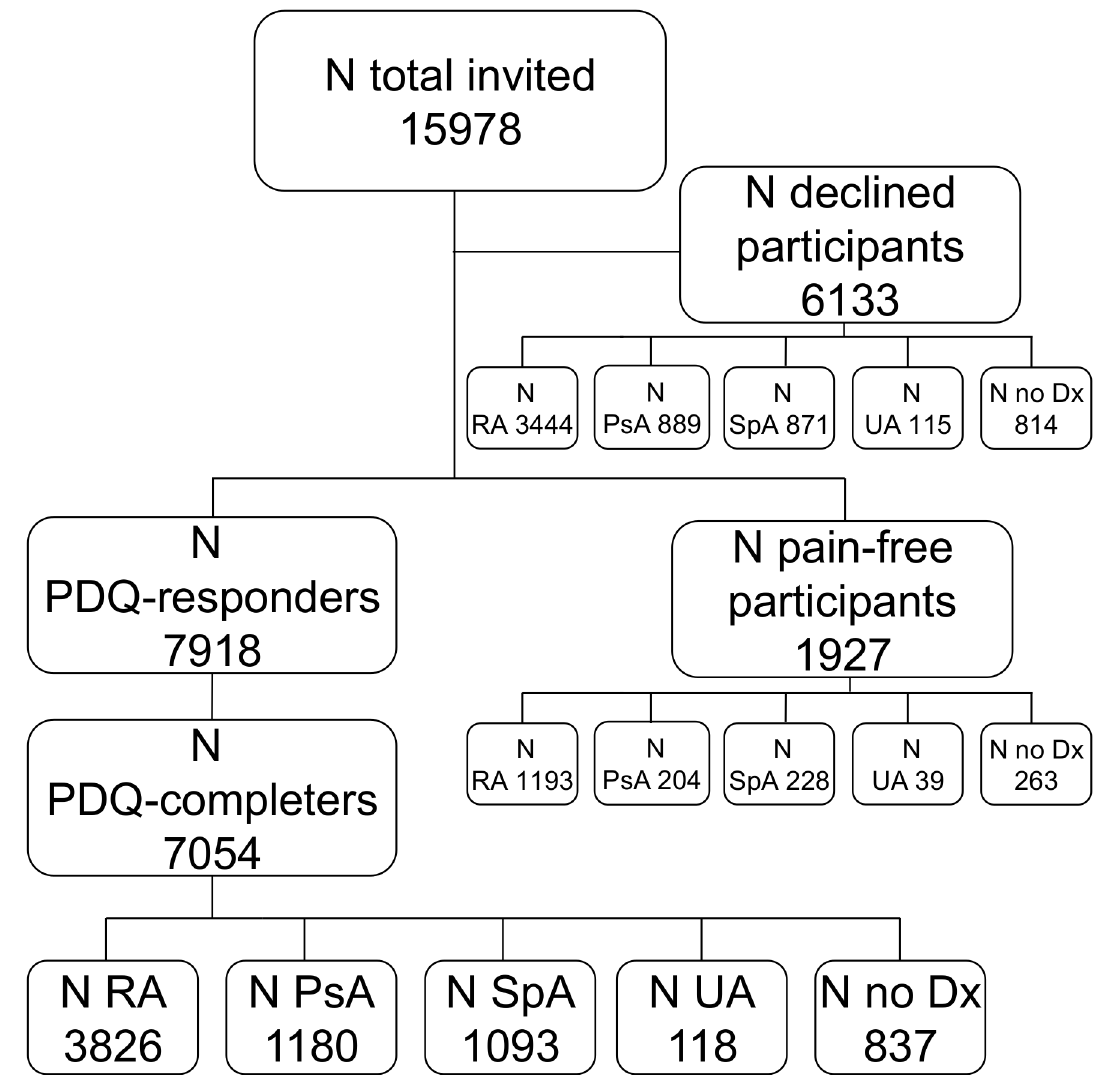
Fig 1. Flowchart of possible participants in the painDETECT survey. RA: rheumatoid arthritis; PsA: psoriatic arthritis; SpA: other Spondyloarthritis; UA unspecified arthritis; Dx: